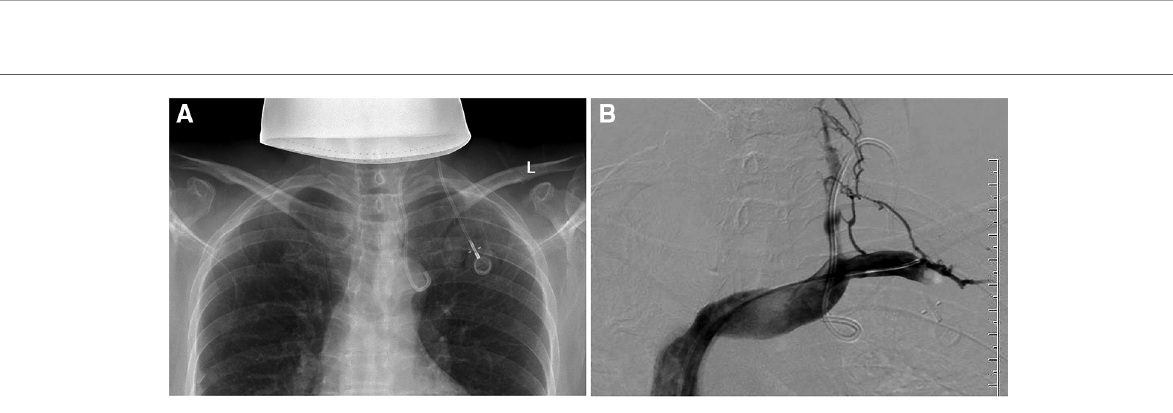
FIGURE 4 Catheter malposition to an unde fi ned collateral vein. ( A ) Chest x -ray shows that the tip of the catheter is located at the aortic arch; ( B ) Fluoroscopy showed that the tip of the catheter turns back into an angle under the left clavicle, and DSA radiography shows that the vein where the catheter is located is not visible, considering that the head end enters the venule